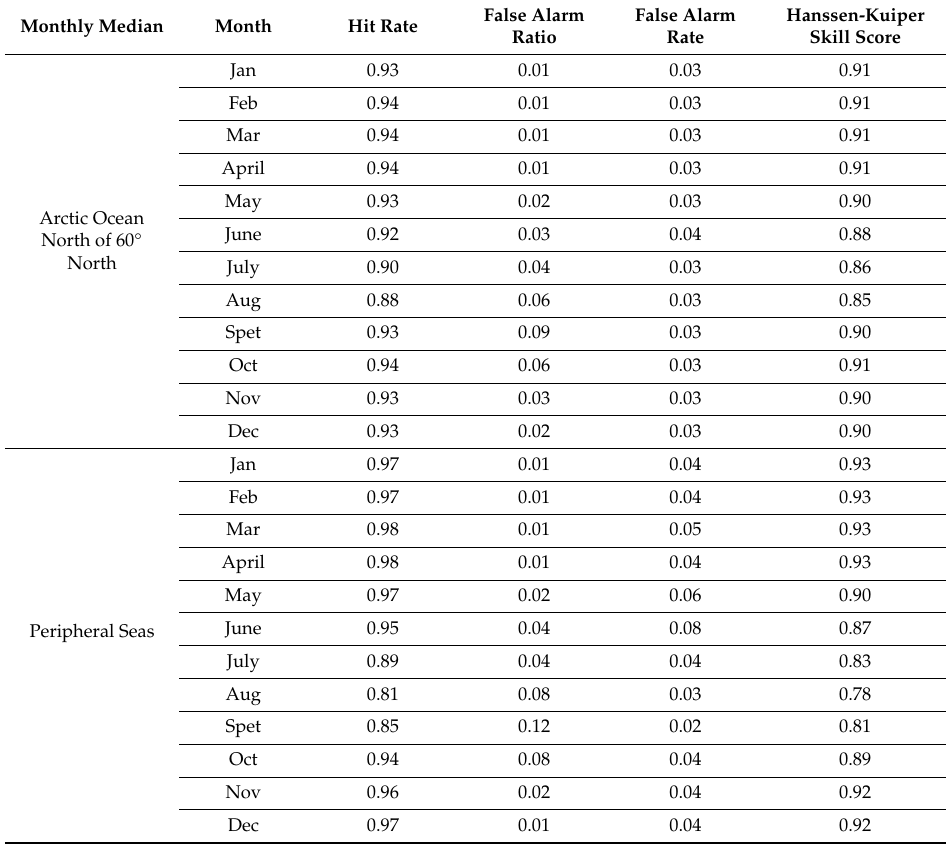
Table 2. Monthly median Hit Rate, False Alarm Ratio, False Alarm Rate, and Hanssen-Kuiper Skill Score over the Arctic Ocean poleward of 60 ◦ North and over the Peripheral Seas of the Arctic Ocean. Monthly Median Month Hit Rate